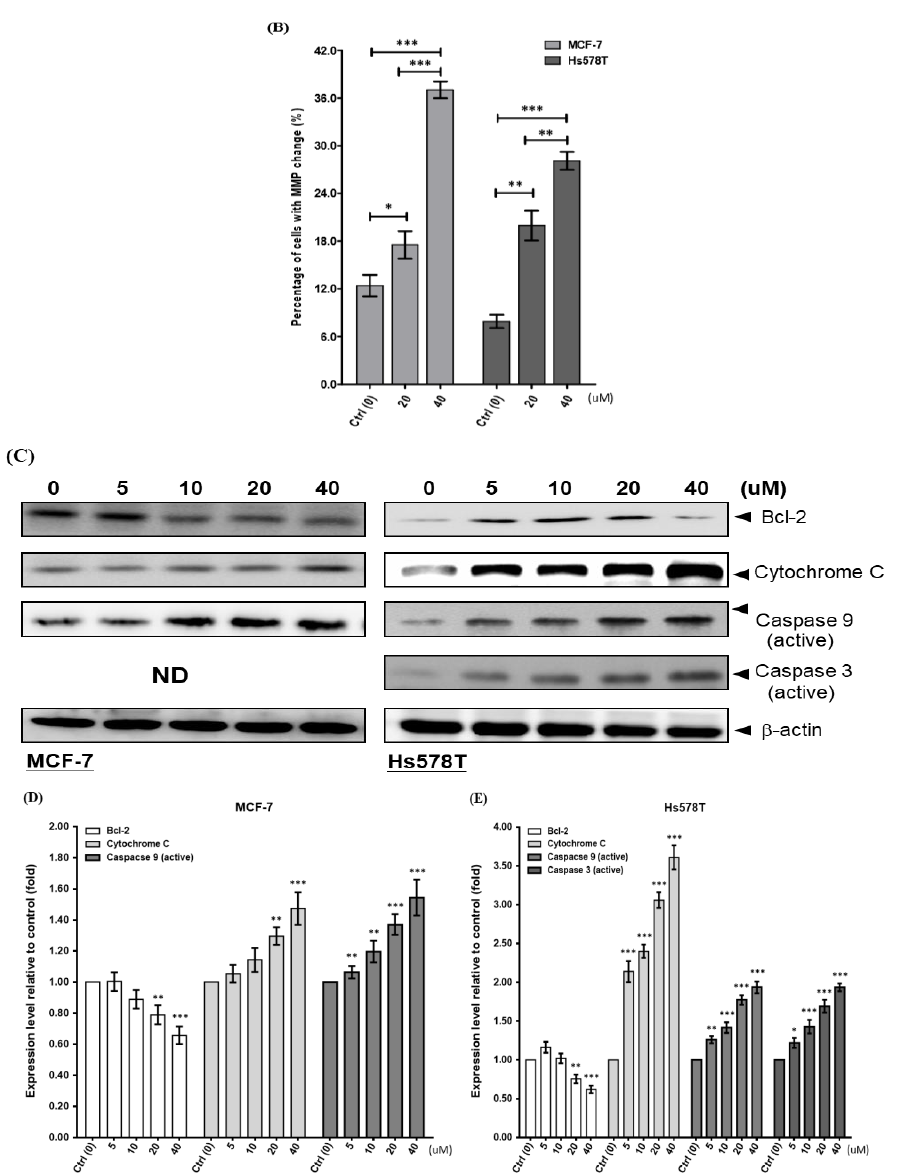
Figure 4. Diosgenin dissipates the mitochondrial membrane potential ( ∆Ψm ) in breast cancer cells. ( A ) Images of JC-1 fluorescence were taken at 48 h. Red fluorescence indicates aggregates of JC-1 in intact mitochondria, whereas green fluorescence represents the JC-1 monomer in cytosol. MCF-7 and Hs578T cells treated with vehicle are shown in ( a , b , e , f ), respectively. MCF-7 and Hs578T cells treated with 20 µM diosgenin are shown in ( c , d , g , h ), respectively. Arrows indicate the translocation of JC-1 from mitochondria ( a , e ) to cytosol ( d , h ). ( B ) Quantitation of the flow cytometric analysis of diosgenin-treated MCF-7 (left panel) and Hs578T (right panel) cells showing loss of the ∆Ψm . Data are shown as means ± SD for three independent experiments. * p < 0.05, ** p < 0.01, and *** p < 0.001 vs. control (Ctrl, 0 µM) cells. ( C ) Breast cancer cells were treated with various concentrations of diosgenin for 48 h. Western blot analyses with antibodies to apoptosis-relevant proteins. β -actin was used as the loading control. ( D , E ) Protein levels were determined by Western blot analyses using specific antibodies to the indicated cell cyclins. β -actin was used to normalize the amount of protein in each lane. Data are shown as means ± SD for three independent experiments. * p < 0.05, ** p < 0.01, and *** p < 0.001 vs. control (Ctrl, 0 µ M)